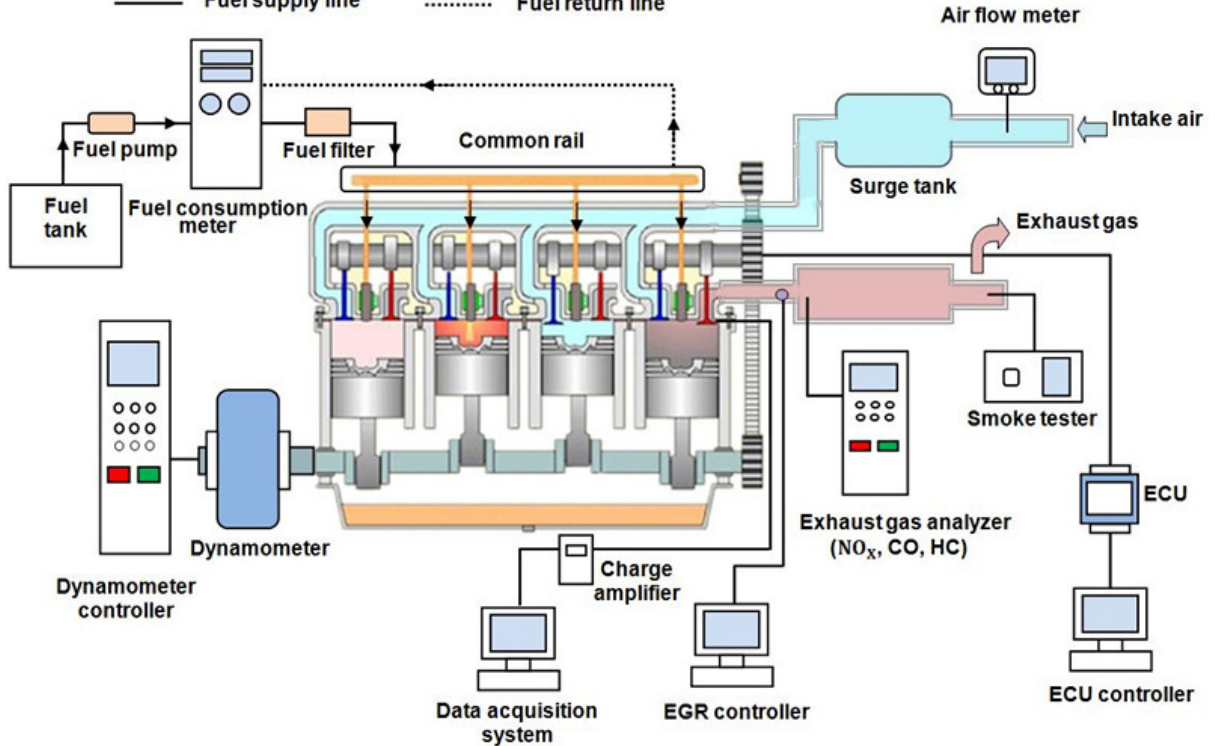
Figure 1. Schematic diagram of the experimental